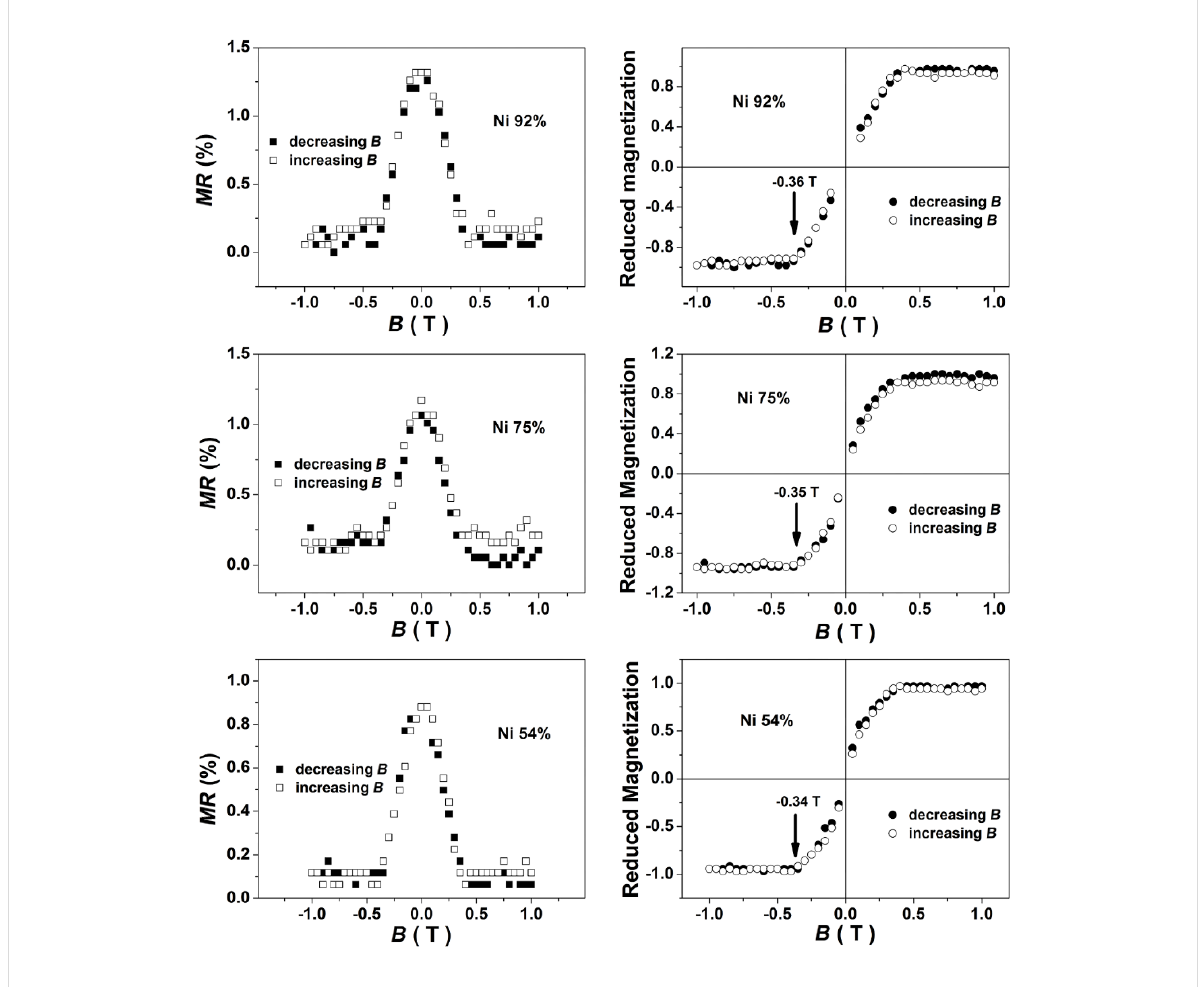
Figure 3: The perpendicular magnetoresistance as a function of the induction of the magnetic field (left column) and the corresponding magnetization reversal in perpendicular geometry (right column) as calculated via Equation 5, for single Ni–Cu alloy nanowires of different Ni